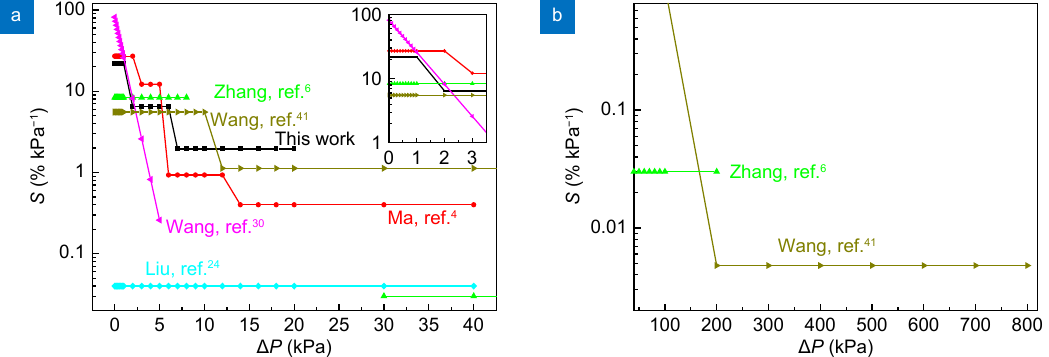
Fig. 8 | Sensitivity variations with pressure of this work and typical references 4,6,24,30,41 . ( a ) Within 40 kPa pressure. ( b ) Over 40 kPa